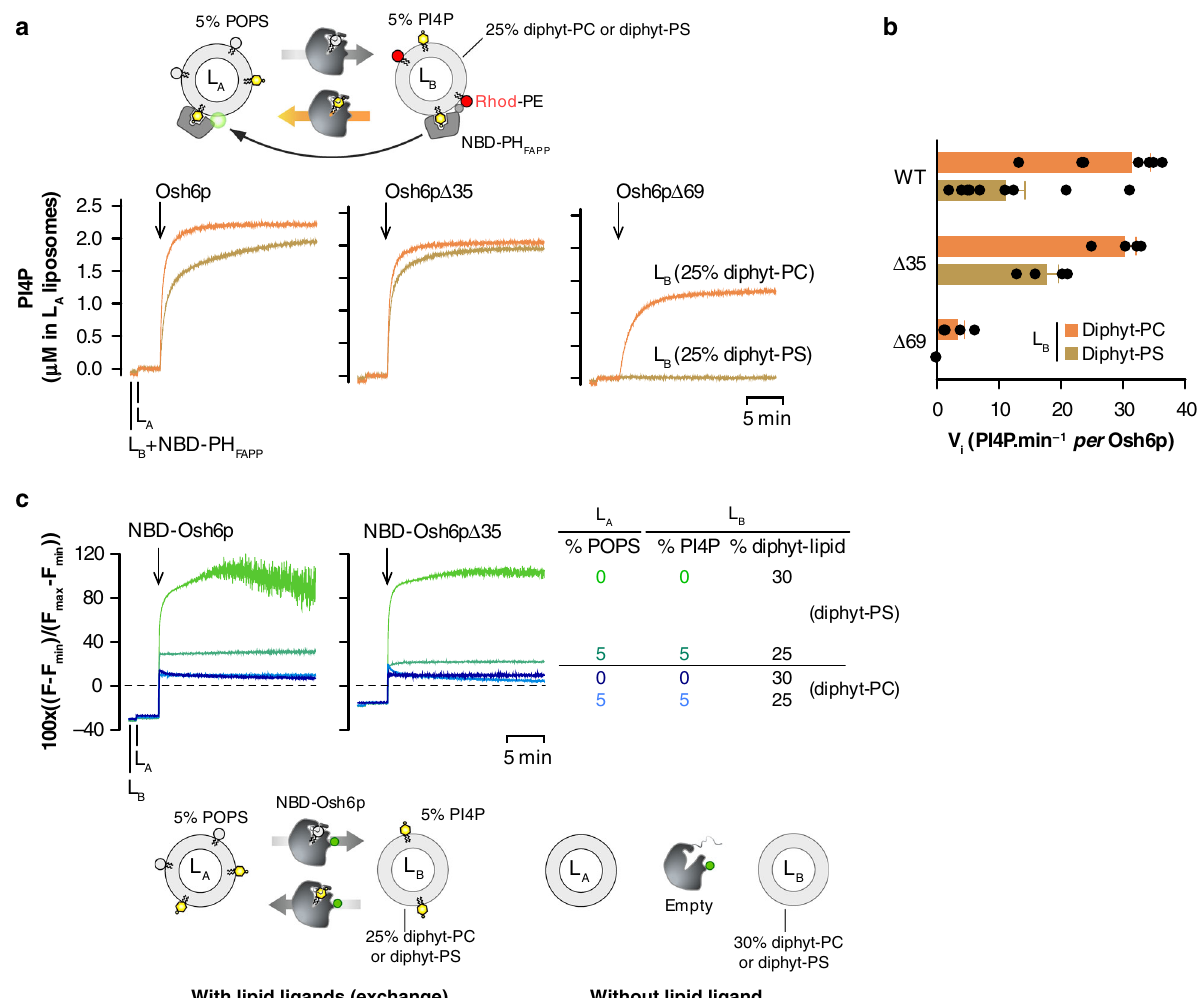
Fig. 5 Osh6p remains mostly soluble during PS/PI4P exchange between anionic membranes. a PI4P transport assay. L B liposomes (200 µ M total lipids), consisting of DOPC, diphytanoyl-PC, diC16:0-PI4P and Rhod-PE (68/25/5/2 mol/mol) or DOPC, diphytanoyl-PS, diC16:0-PI4P and Rhod-PE (68/25/5/2 mol/mol) were incubated with NBD-PH FAPP (250 nM) in HK buffer at 30 °C. Then DOPC liposomes (200 µ M lipids, L A ) doped with 5% POPS were added. After 2 min, Osh6p, Osh6p Δ 35 or Osh6p Δ 69 (200 nM) was injected. The dequenching of the NBD signal mirrors the translocation of NBD-PH FAPP from L B to L A liposomes due to the transport of PI4P. The signal is normalized in term of amount of PI4P delivered into L A liposomes. b Initial PI4P transport rates of each Osh6p construct measured with L B liposomes containing diphytanoyl-PC (orange bar) or – PS (brown bar). The rates, represented as mean ( n = 4 – 9), were determined from experiments as shown in ( a ). c Time evolution of the binding of NBD-labeled wild-type Osh6p or its Δ 35 counterpart to L A and L B liposomes. L A Liposomes, incorporating or not 5% POPS were added to L B liposomes, comprising 25% of either diphytanoyl-PS or -PC, doped or not with 4% diC16:0-PI4P, in HK buffer at 30 °C. Then, NBD-Osh6p WT or Δ 35 was added (200 nM). The fl uorescence was followed at 535 nm ( λ ex = 460 nm) over 20 min and normalized. Each trace is representative of several experiments. The dashed line corresponds to the NBD signal measured from the protein in buffer alone and which corresponds to zero after normalization. Error bars correspond to s.e.m. Source data are provided as a Source Data fi